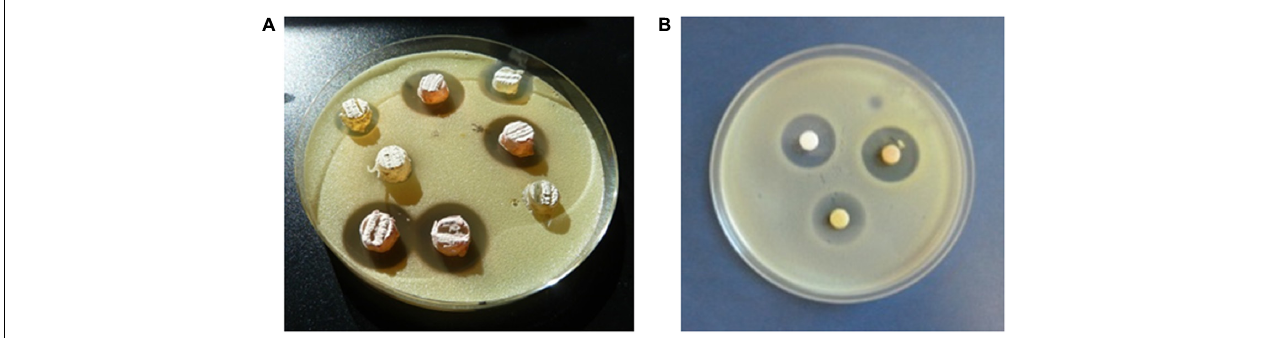
FIGURE 2 | Bioassay diffusion assays. Micrococcus luteus was used as indicator microorganism. The zones of complete inhibition are measured as the diameters in mm. (A) Agar plugs. (B) AA discs loaded with ethyl acetate extracts of the isolates.